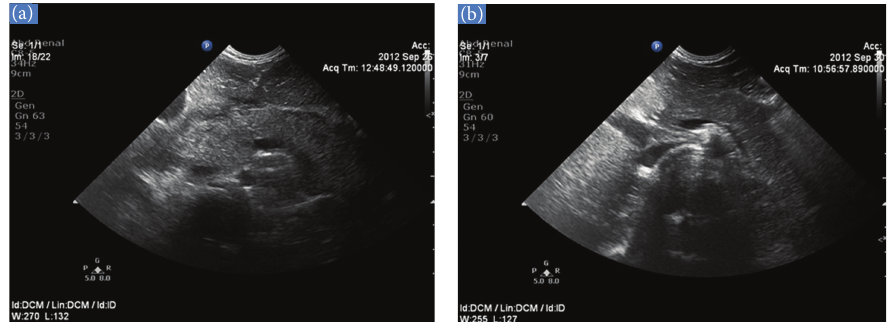
Figure 1: (a) Abdominal ultrasound on admission. Upper abdominal transverse section showing generalized enlargement of the pancreatic gland with a slightly heterogenous parenchyma and an overall reduction in reflectivity. Peripancreatic fluid collections are also noted. (b) Abdominal ultrasound on the 5th hospital day. Upper abdominal transverse section showing normalization of the size of the pancreas and complete resorption of the peripancreatic fluid